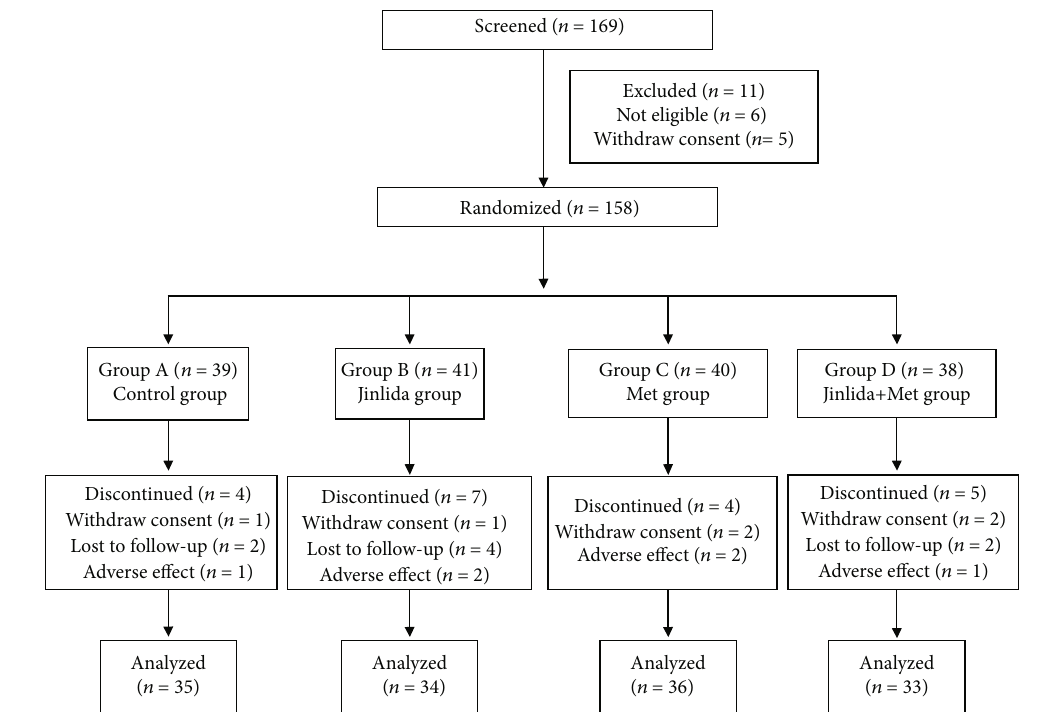
Figure 1: Study design and participant fl ow diagram. Table 1: Baseline characteristics of the subjects in the